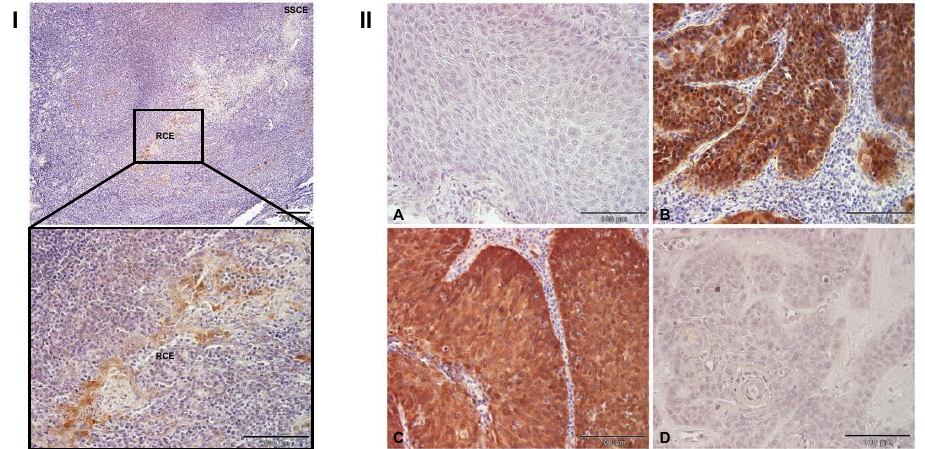
Figure 1. Immunohistochemical analysis of p16 expression. Paraffin-embedded biopsies were immunostained for p16, counterstained with hematoxylin, and visualized by a light microscope. Representative images: ( I ) Positive p16 immunoreactivity is seen in the reticulated crypt epithelium (RCE) but not in the superficial squamous cell epithelium (SSCE). ( II ) A. No p16 immunoreactivity was detected in the majority of HPV-negative OPSCCs. B. p16 immunoreactivity was seen in a few HPV-negative OPSCCs. C. p16 immunoreactivity was detected in the majority of HPV16-positive OPSCCs. D. No p16 immunoreactivity was seen in a few HPV16+ OPSCCs. Scale bars = 200 µ m and 100 µ m ( I ); 100 µ m ( II A–D).